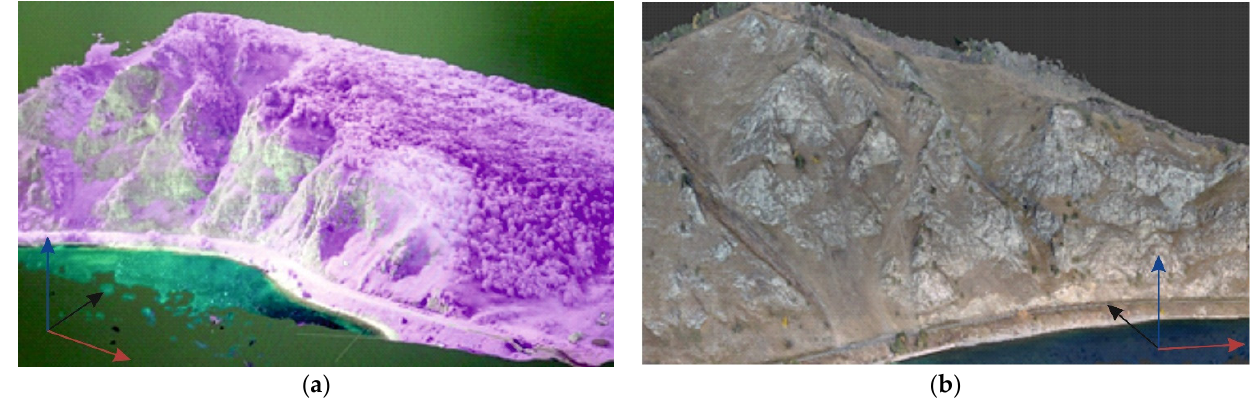
Figure 7. DTM obtained when shooting with two camera tilt angles: nadir and 45 degrees: ( a ) OCN camera; ( b ) RGB camera.